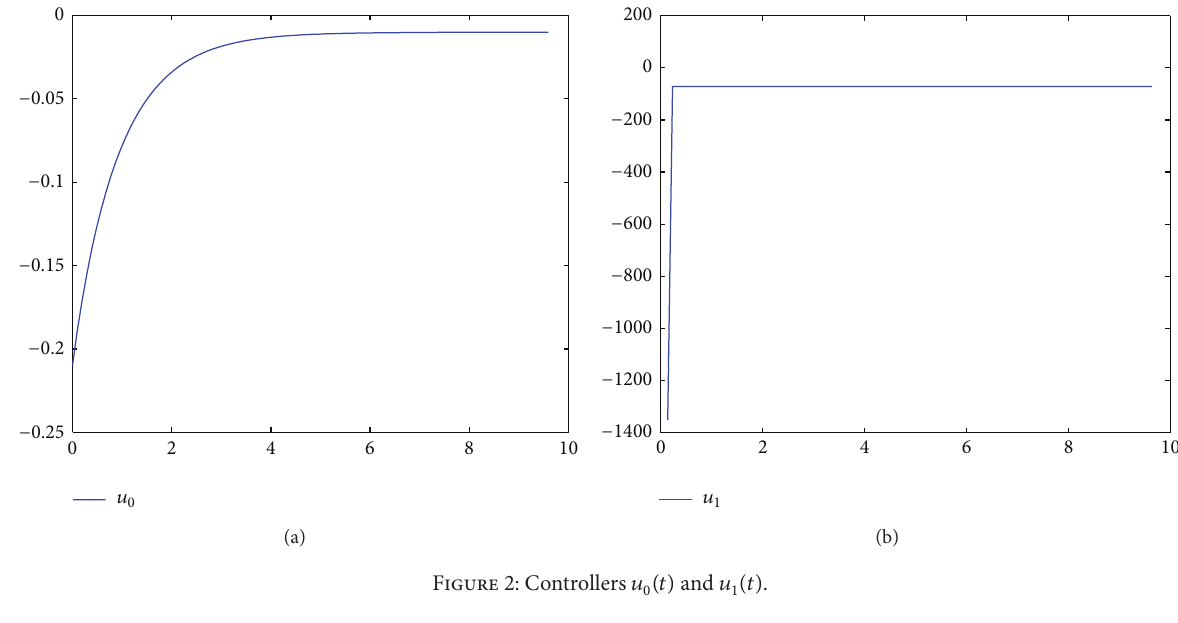
Figure 2: Controllers 𝑢 0 (𝑡) and 𝑢 1 (𝑡)